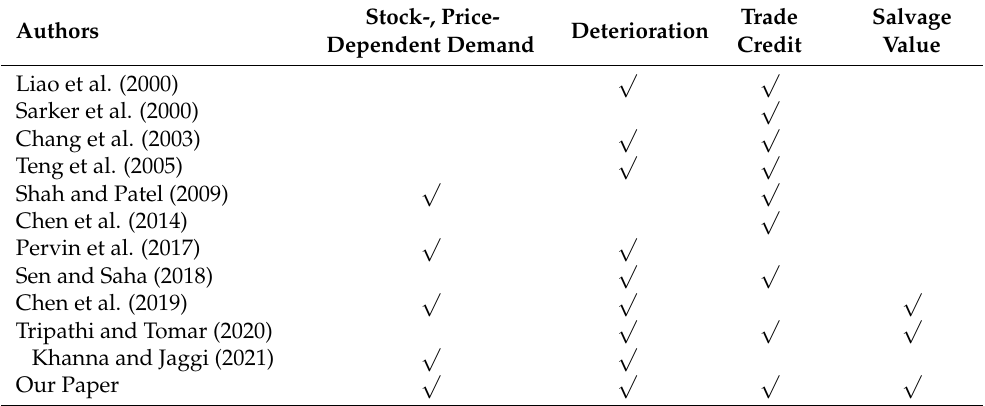
Table 1. The model-related contributions of various